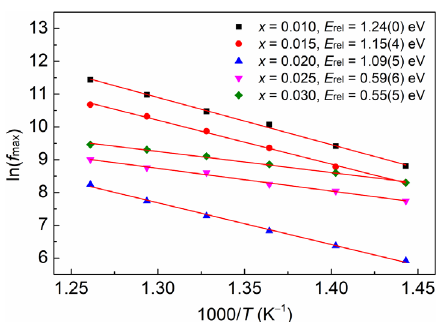
Fig. 9 Arrhenius plots of relaxation frequency for (1 − x )KNN– x BZN ceramics with different BZN contents. The red lines show linear fitting.